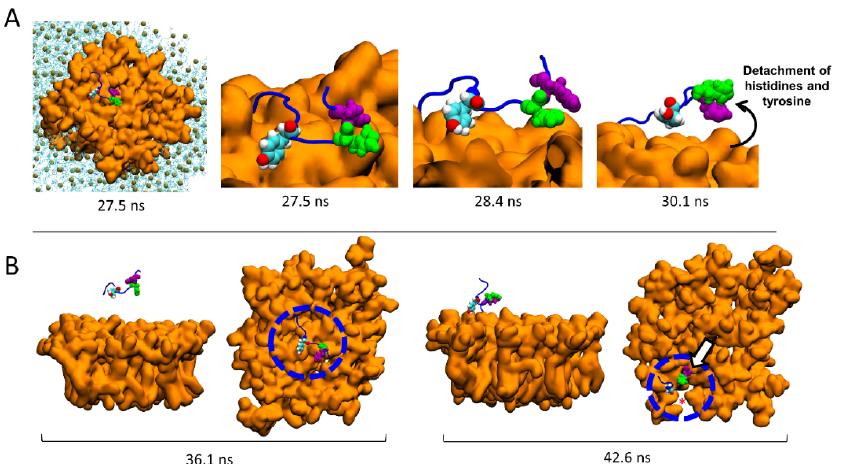
Figure 6. Molecular details of the interaction pathway of AmyP53 at the center of the lipid raft. ( A ) Initial conformation of AmyP53 above the sugar surface of GM1 cluster in front view (top snapshot) or top view (bottom snapshot). GM1 are represented as orange surface, phospholipids are represented as blue lines, and phosphorus atom of phospholipids are depicted as ochre spheres. ( B ) Molecular details of the reversal effect showing that H9 is favored over H10 to interact with the sugar surface of the lipid raft. AmyP53 is represented as blue cartoon in which Y6 is depicted as spheres colored by atom name, H9 is depicted as green spheres, and H10 is depicted as purple spheres. ( C ) Snapshots of three different conformations adopted by AmyP53 in the central area of the GM1 cluster. GM1 are depicted as thin orange lines, and atoms of GM1 that are at least at 3 Å of AmyP53 are represented as orange spheres. AmyP53 is represented as blue cartoon for which Y6 is depicted as spheres colored by atom name, H9 is depicted as green spheres, H10 is depicted as purple spheres, and all other residues are depicted as tubes colored by atom name.